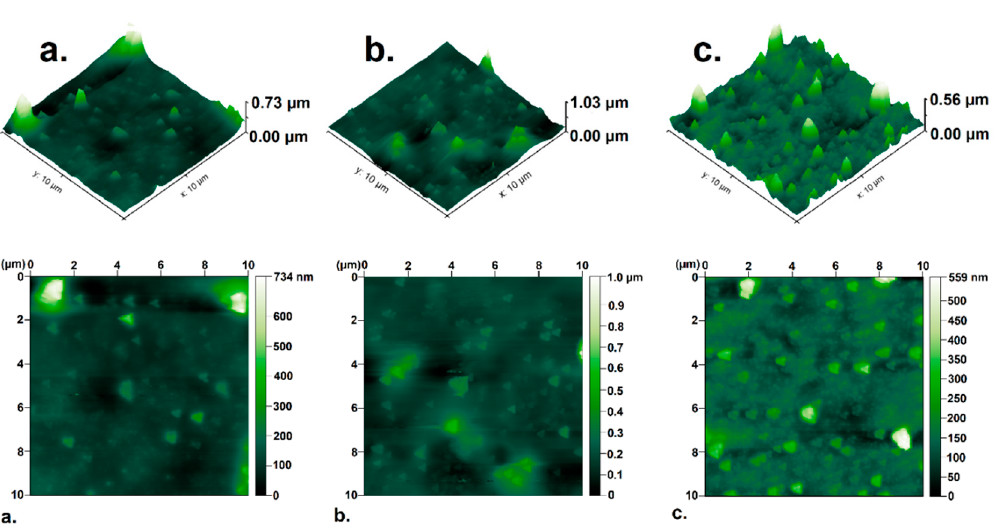
Table 2. Surface roughness values of the different PEEK samples coated with silver.